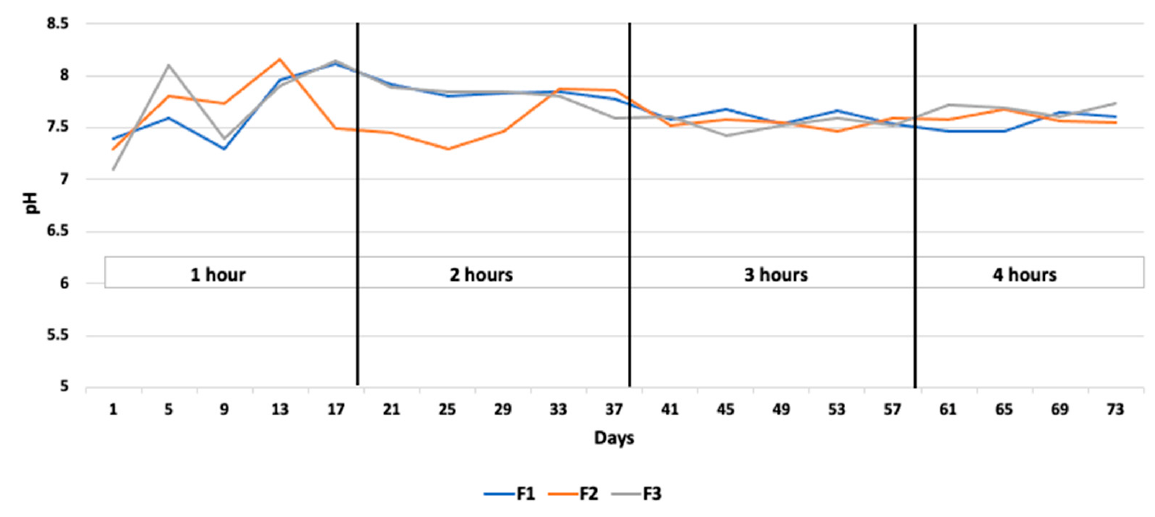
Figure 5. pH levels during the various mixing intervals throughout the experiment.